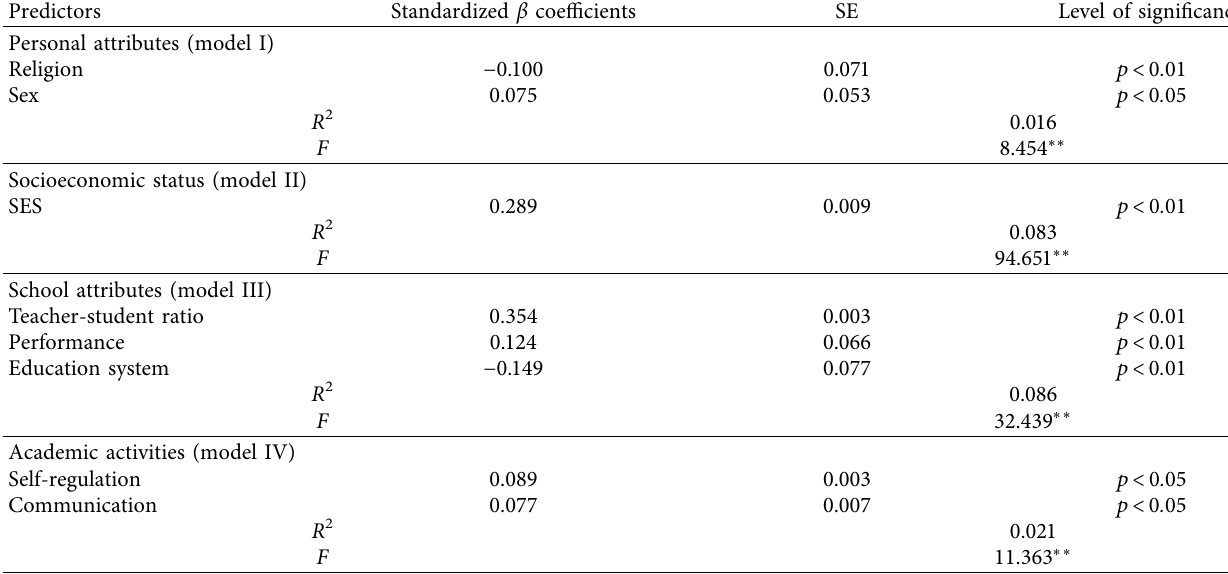
Table 1: Stepwise multivariate regression predicting academic achievement considering four separate sets of variables.